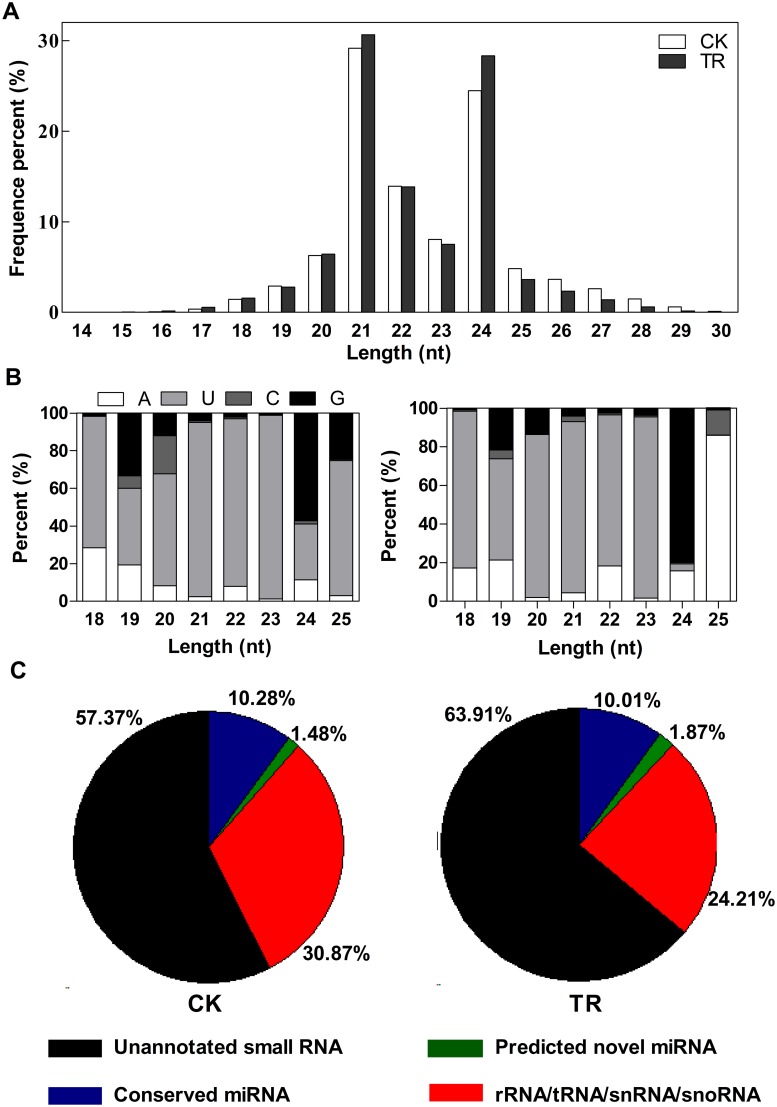
Length distribution (A), first nucleotide bias (B) and composition (C) of the small RNA in CK and TR libraries.